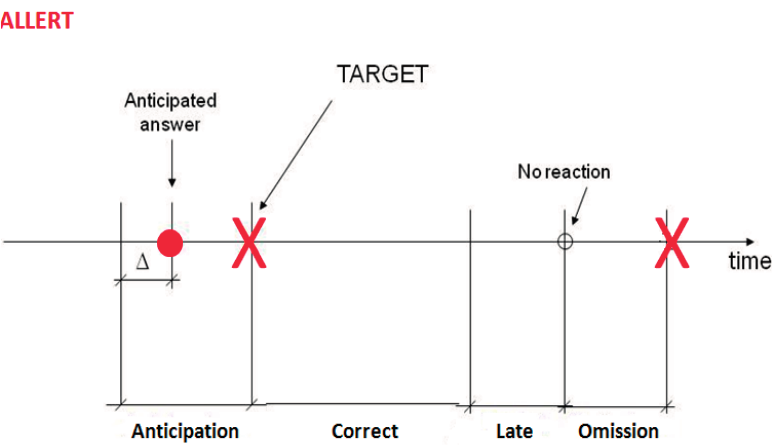
Figure 2. Alert task: The TARGET is the stimulus shown on the screen and the subject has to answer to it as soon as possible. The possible reaction times could be: early, correctly, late or no